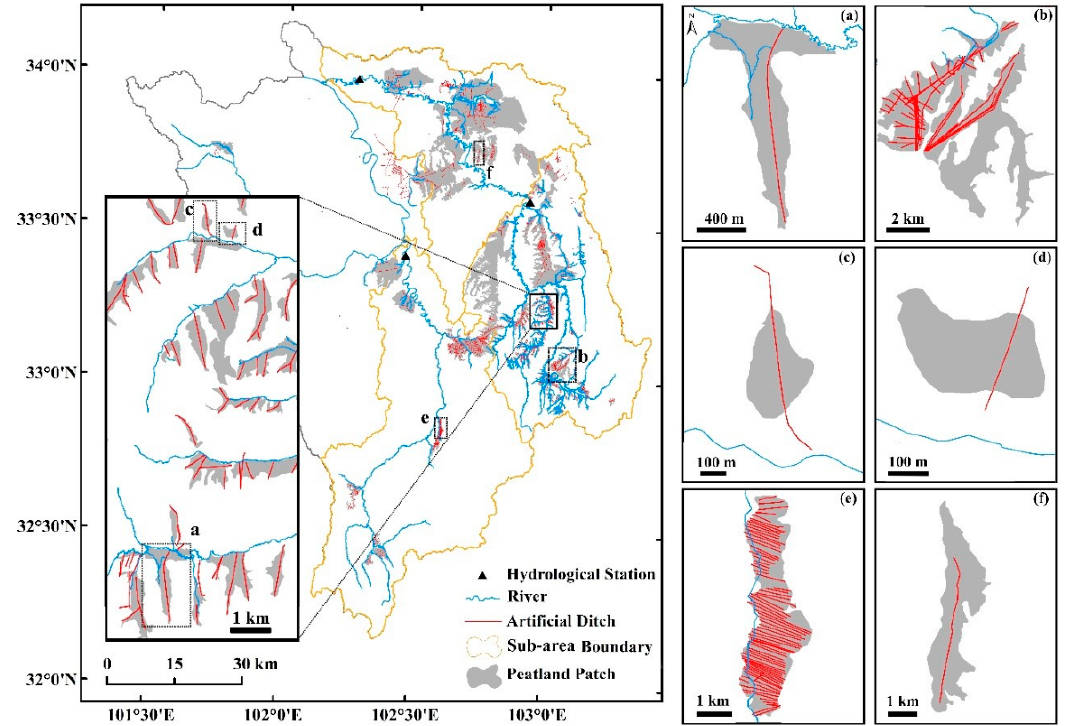
Figure 4. Examples of peatland patches that had specifically different structures: ( a , b ) had different patch areas with similar ditch densities; ( c , d ) had similar larger patch areas with different values of I index; and ( e , f ) had similar smaller patch areas with different values of I index.